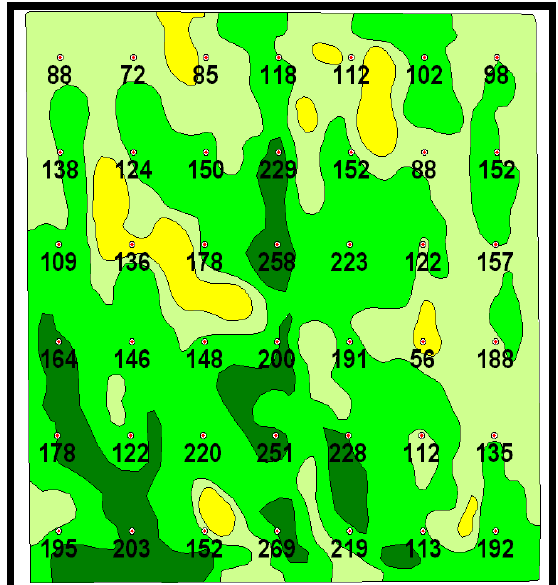
Figure 5. Landsat TM derived NDVI map of sugar beet canopy. Biomass increase from yellow (least) through progressively darker shades of green. A map of nitrogen credits is created from the available